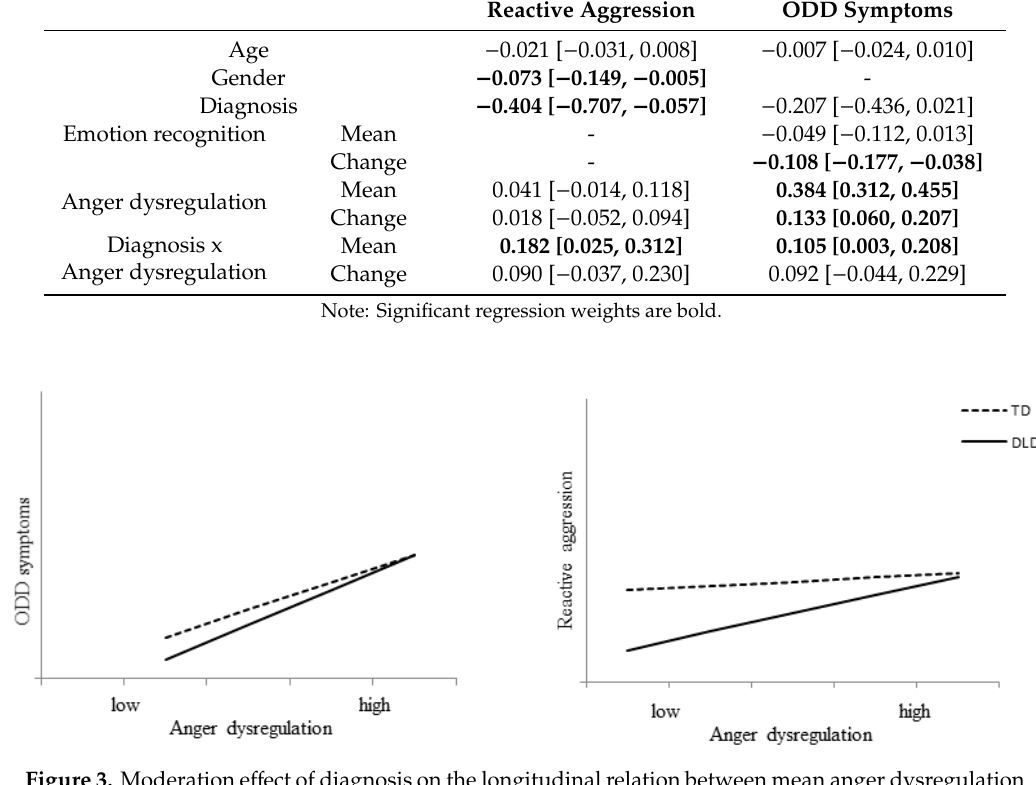
Figure 3. Moderation effect of diagnosis on the longitudinal relation between mean anger dysregulation and externalizing problems for children with Developmental Language Disorder (DLD) and typically developing children (TD).